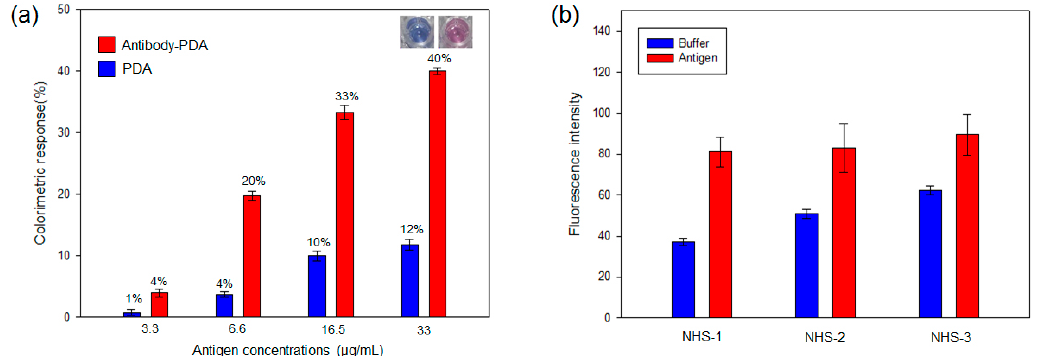
Figure 1. ( a ) Colorimetric response (CR%) of the antibody-PDA conjugates and unfunctionalized PDA against antigen concentrations. Inset shows the noticeable color change of antibody-PDA conjugate after the addition of virus antigen (33 µ g/mL); ( b ) Fluorescence intensity of the antibody-PDA conjugates in the absence and presence of virus antigen. (NHS-1 = 10% NHS-PCDA, NHS-2 = 20% NHS-PCDA and NHS-3 = 30% NHS-PCDA) The virus antigen was added to the PDA system and incubated at 37 °C for 10 min.